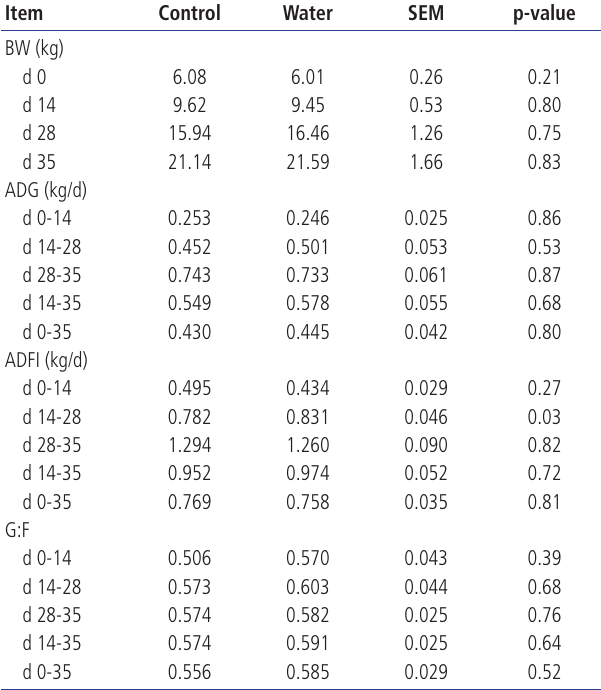
and E administration in 3 , E injection (experiment 2) 1)-3) 3